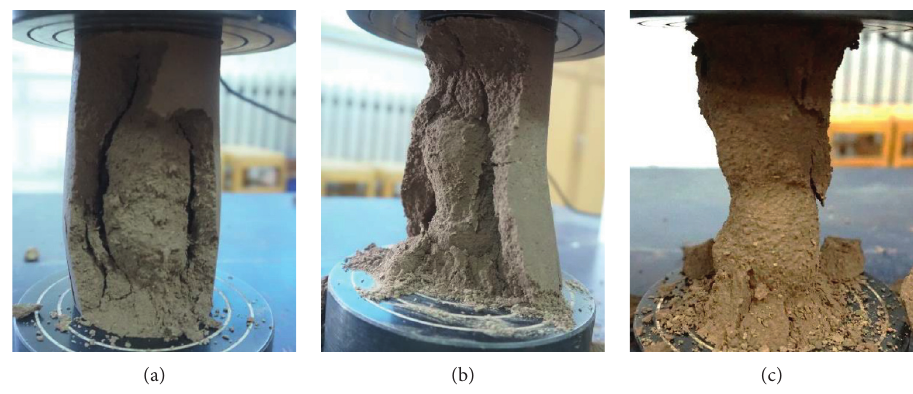
Figure 6: Compacting slurry veins in the reinforced